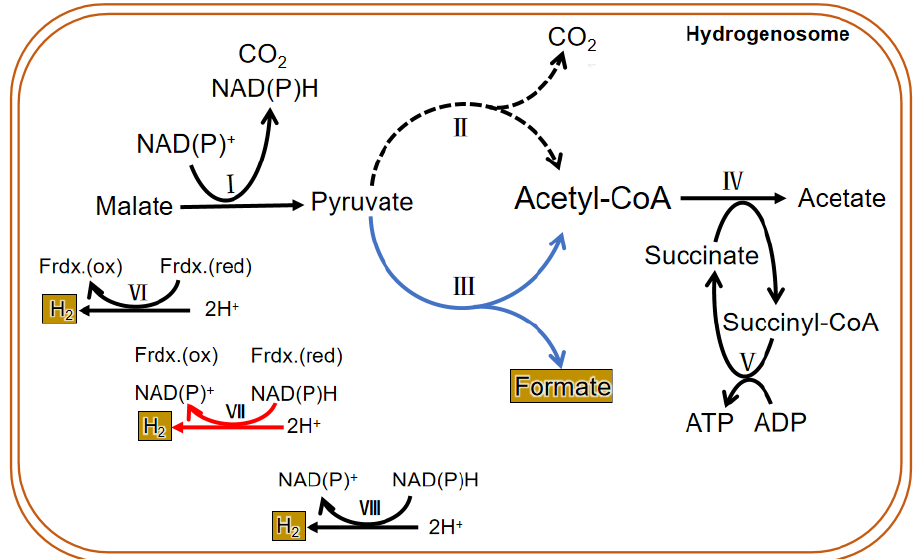
Figure 5. Metabolic process in the hydrogenosome of both trichomonas and anaerobic fungi. The dotted line is the main metabolic pathway of trichomonas hydrogenosomes. The blue line represents the main hydrogenosomal metabolism pathway of anaerobic fungi. The black line is the common metabolic pathway of both of them. The red line shows a suspected H 2 generation pathway, and it commonly exits in both. Ⅰ . malic enzyme; Ⅱ . pyruvate: ferredoxin oxidoreductase (PFO); Ⅲ . pyruvate formate lyase (PFL); Ⅳ . acetate: succinyl CoA-transferase; Ⅴ . succinyl-CoA synthetase; Ⅵ . ferredoxin hydrogenase; Ⅶ . bifurcating hydrogenase; Ⅷ . hydrogen dehydrogenase.